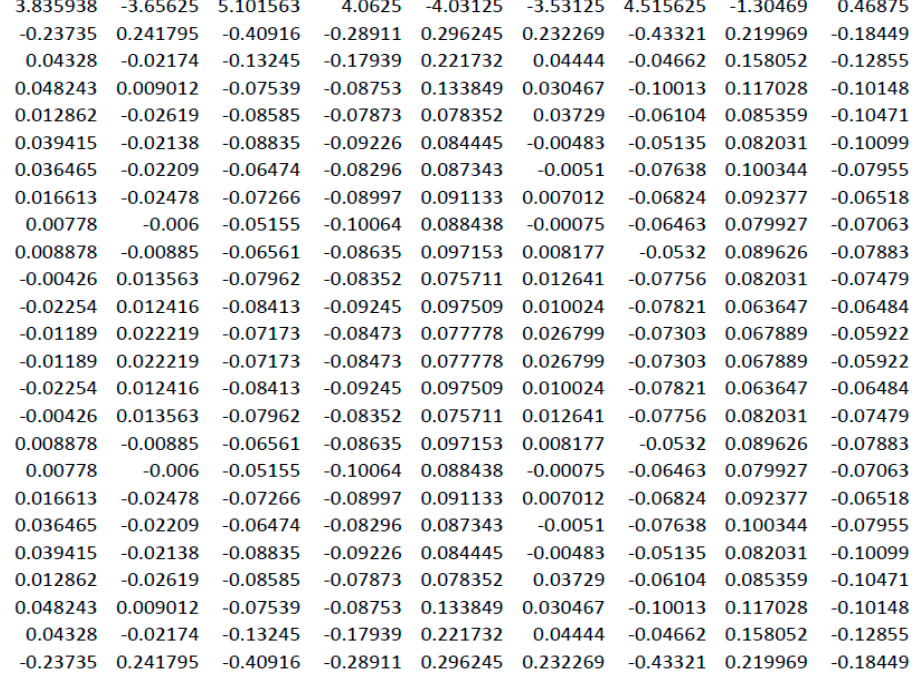
Figure 8. Pulse response captured at 5000 samples per second.